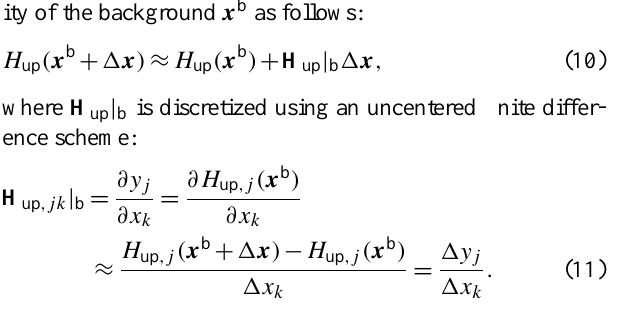
to be uncorrelated and the variances are estimated statis- tically to represent the variability of the upstream